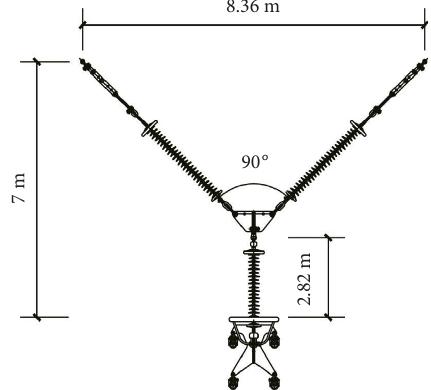
Figure 16: Te I -type section optimization of the Y -type insulator string.